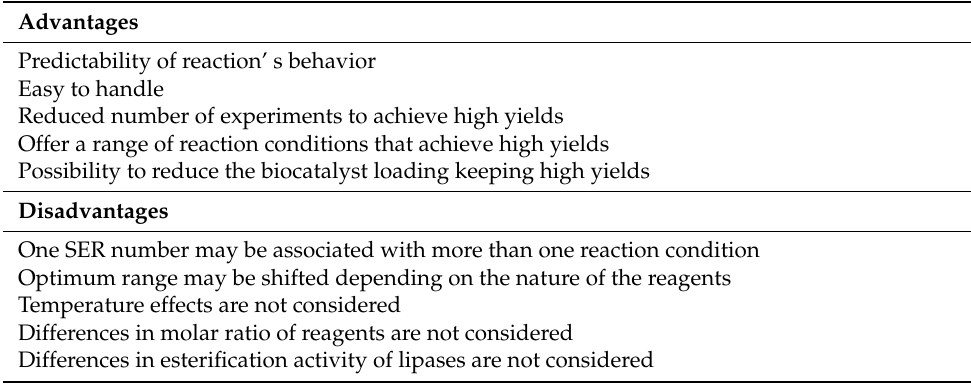
Table 6. Advantages and disadvantages of